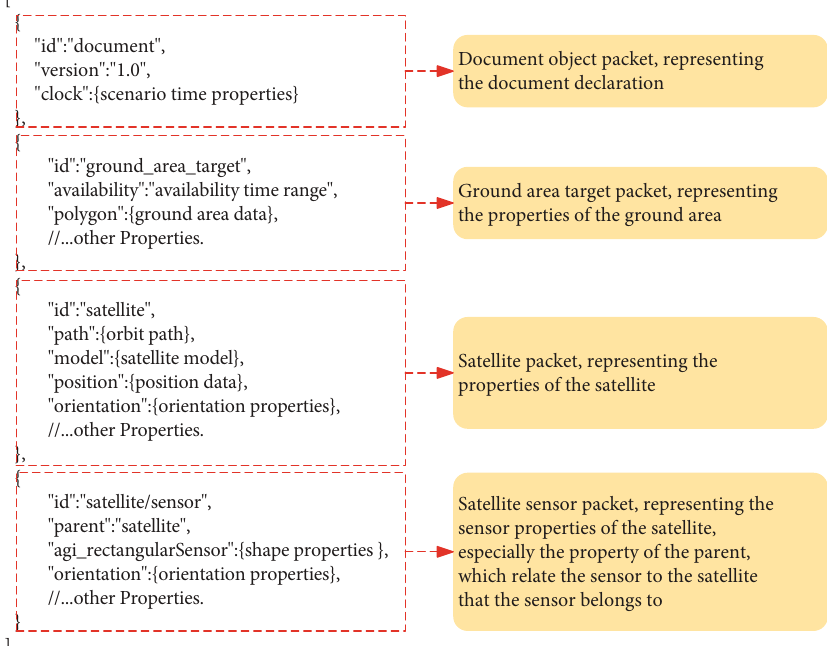
Figure 2: CZML data format for the satellite coverage analysis scenario. The CZML fi le can be constructed by the program development, and Cesium will display the scenarios by loading these fi